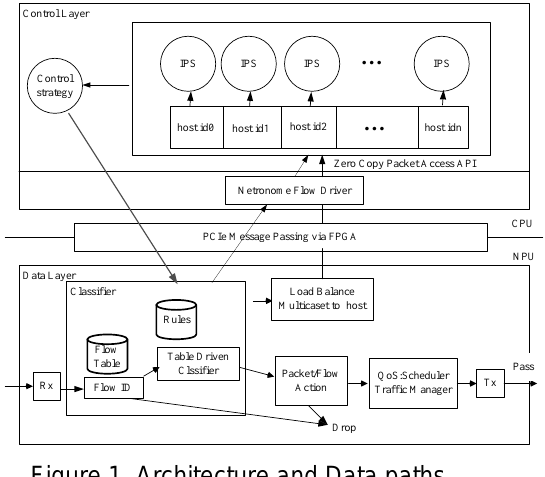
Figure 1 Architecture and Data